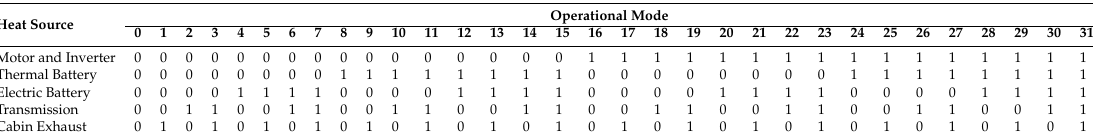
Table 1. List of heat sources, their operational mode options, and an example of how each operational mode is